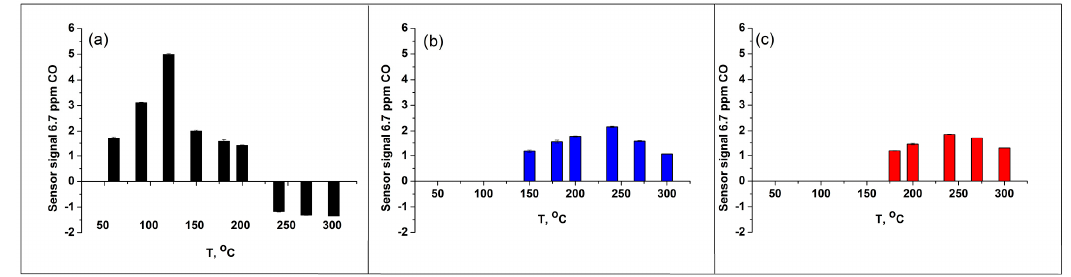
Figure 9. Bar chart showing the 6.7 ppm CO response of the Co 3 O 4 sensor as a function of temperature at 0% r.h. ( a ), 20% r.h. ( b ), and 60% r.h. ( c ). The area of “negative” values in the temperature range 240–300 °C in dry air (part ( a )) corresponds to n-type sensor behavior.